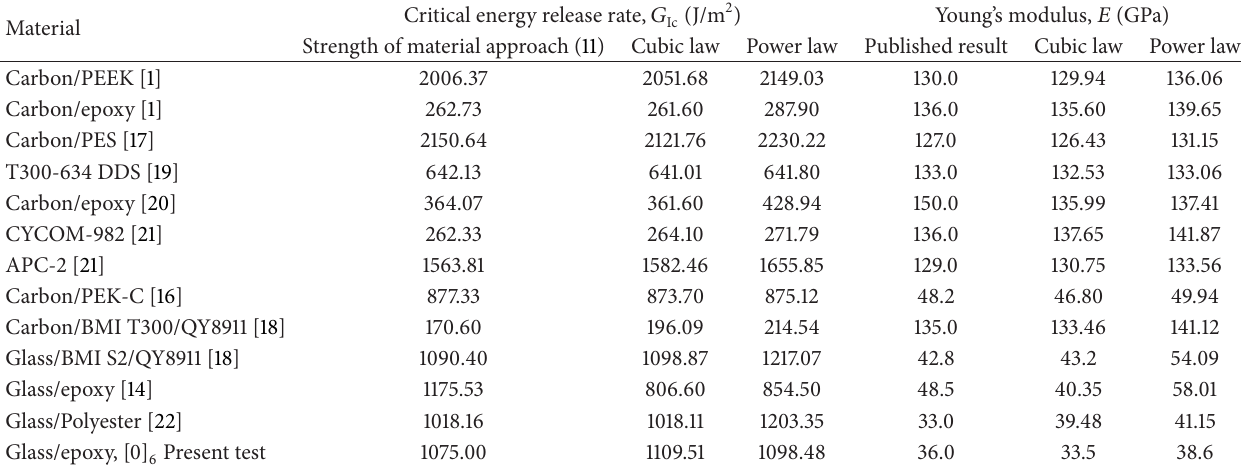
Table 4: Comparison of energy release rate and Young’s modulus of unidirectional composites based on analytical data reduction schemes.